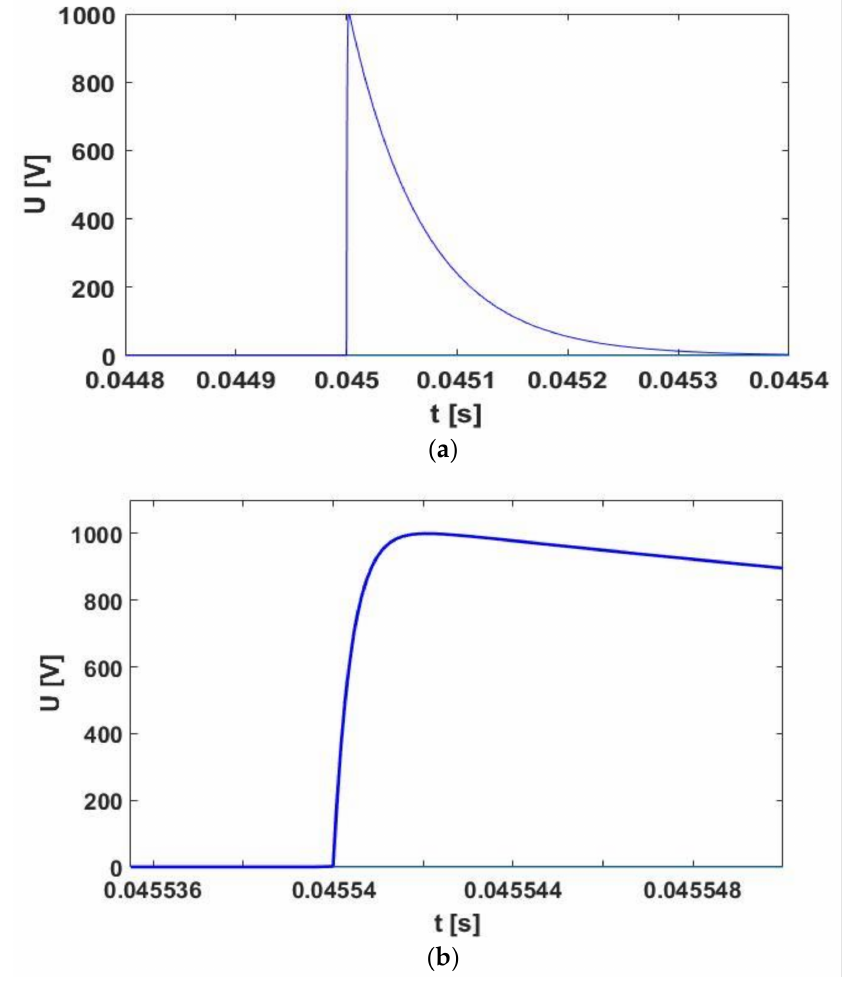
Figure 2. Voltage surge pulse vs. time: ( a ) the whole of the generated waveform; ( b ) view of the fast-changing frontal of the surge